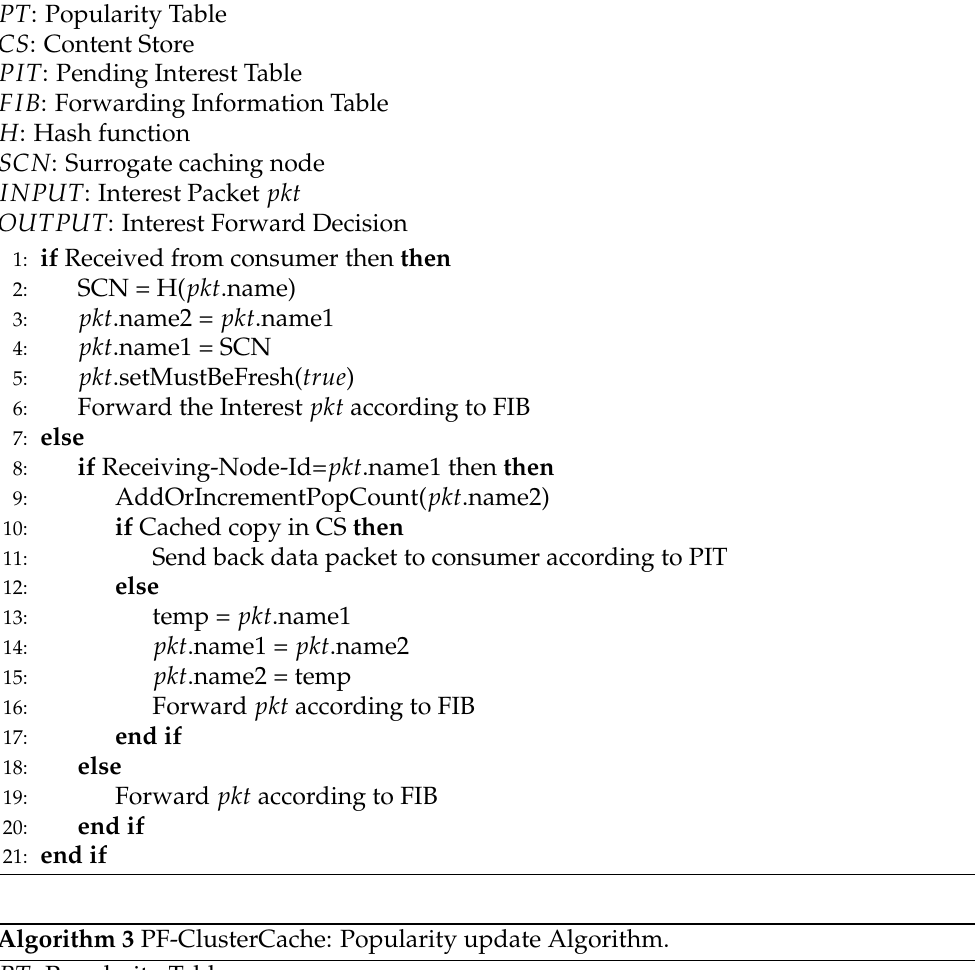
Algorithm 2 PF-ClusterCache: Interest Forwarding Algorithm.